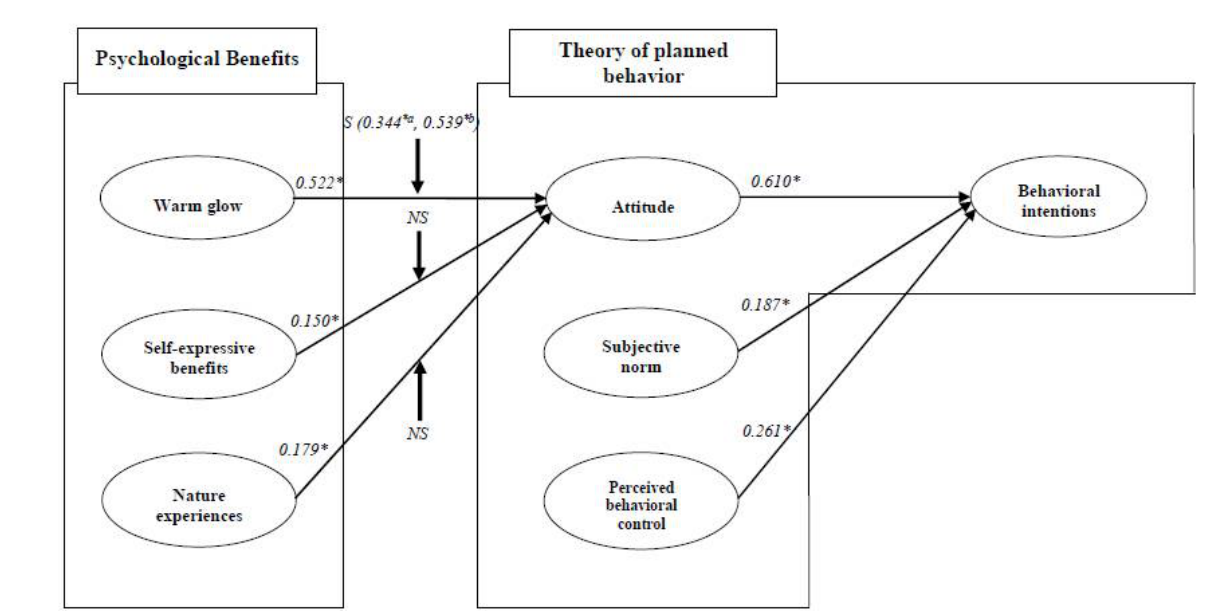
Figure 2. Standardized theoretical path coefficients. Goodness-of-fit statistics: χ 2 = 427.079, df = 173, χ 2 /df = 2.469, p < 0.001, NFI = 0.945, CFI = 0.966, TLI = 0.959, and RMSEA = 0.070. Notes. * p <